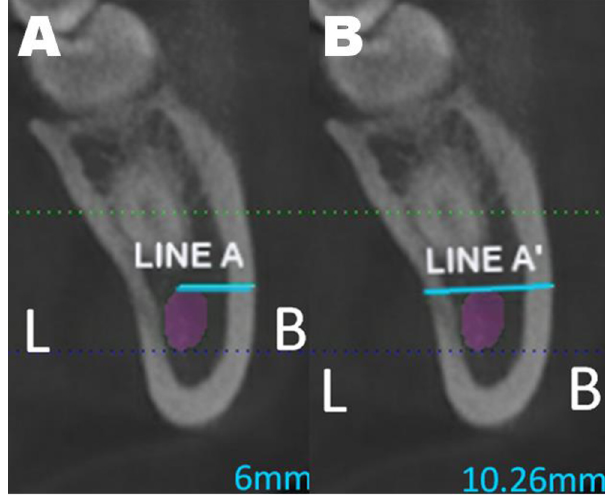
Fig. 2. Diagrammatic representation of measurements on cross- section of mandible at fi rst mandibular molar region (Coronal section). (A) Showing Line A, (B) Line A ’